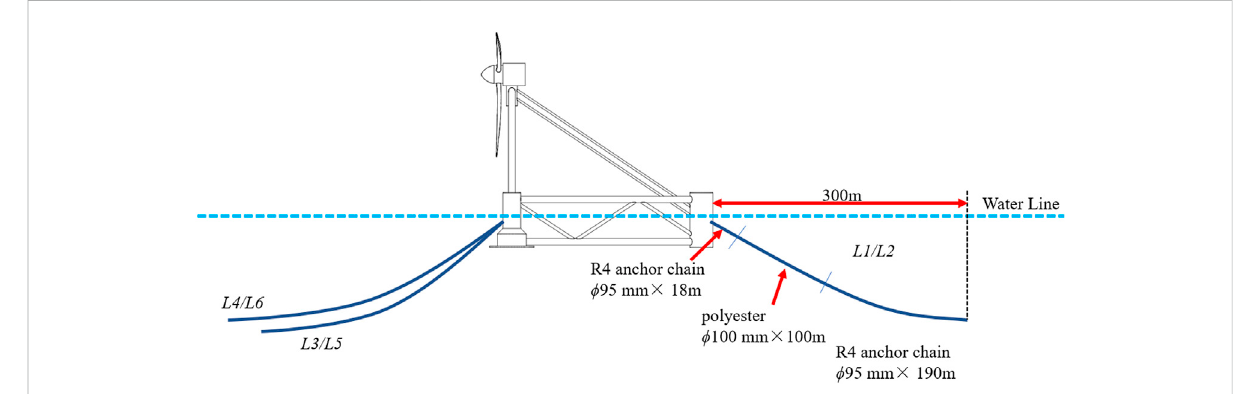
FIGURE 2 Design of mooring system.